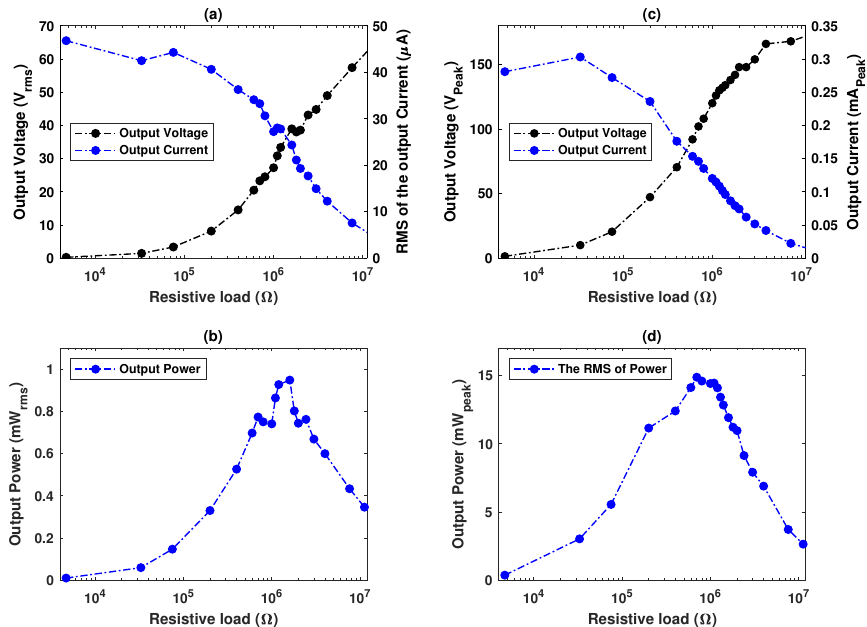
Figure 9. ( a ) RMS of voltage, current, and ( b ) electric power of the piezoelectric vibration energy harvester for piezoelectric benders connected in series at variations of external load resistance. ( c ) Open-circuit voltage, short-circuit current, and ( d ) generated power as a function of the external load resistance for piezoelectric benders connected in series.